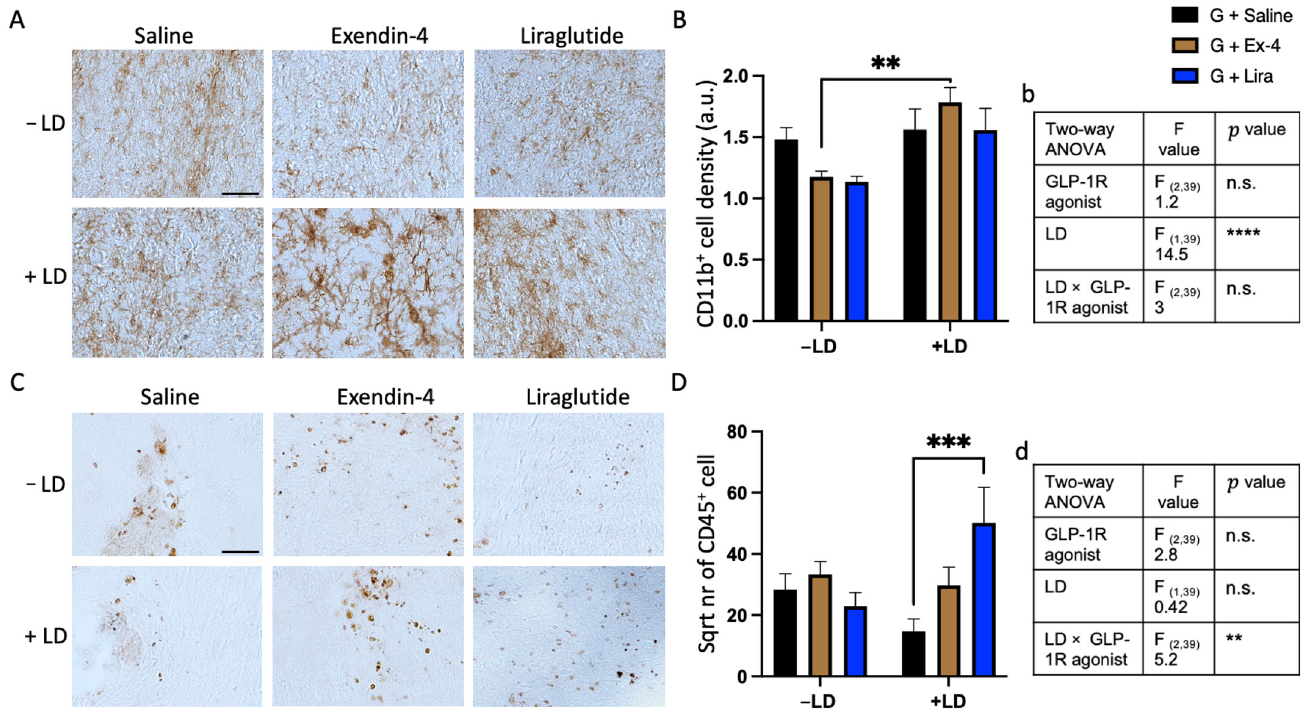
Figure 5. Quantification of CD11b+ microglia and CD45+ leukocyte in the striatum of the grafted rats. ( A , B ) Bright field images showing CD11b+ cells density and morphology around the graft and their quantification respectively in the striatum of the rats received either saline, exendin-4 or liraglutide and +/ − LD. ( C , D ) Bright field images showing CD45+ cells number and their quantification respectively in the striatum of the rats received either saline, exendin-4 or liraglutide and +/ − L-dopa. ( b , d ) illustration of statistical sumary of ( B , D ) analysis respectively. Two way ANOVA ** p < 0.01, *** p < 0.001, **** p < 0.0001. n = G − LD (7), G + LD (8), G − LD + Ex-4 (9), G + LD + Ex-4 (8), G − LD + Lira (6), G + LD + Lira (7). n.s. = not significant LD = L-dopa; Ex-4 = Exendin-4; Lira = Liraglutide TH = tyrosine hydroxylase. Scale bar ( A , C ) = 100 μ m.